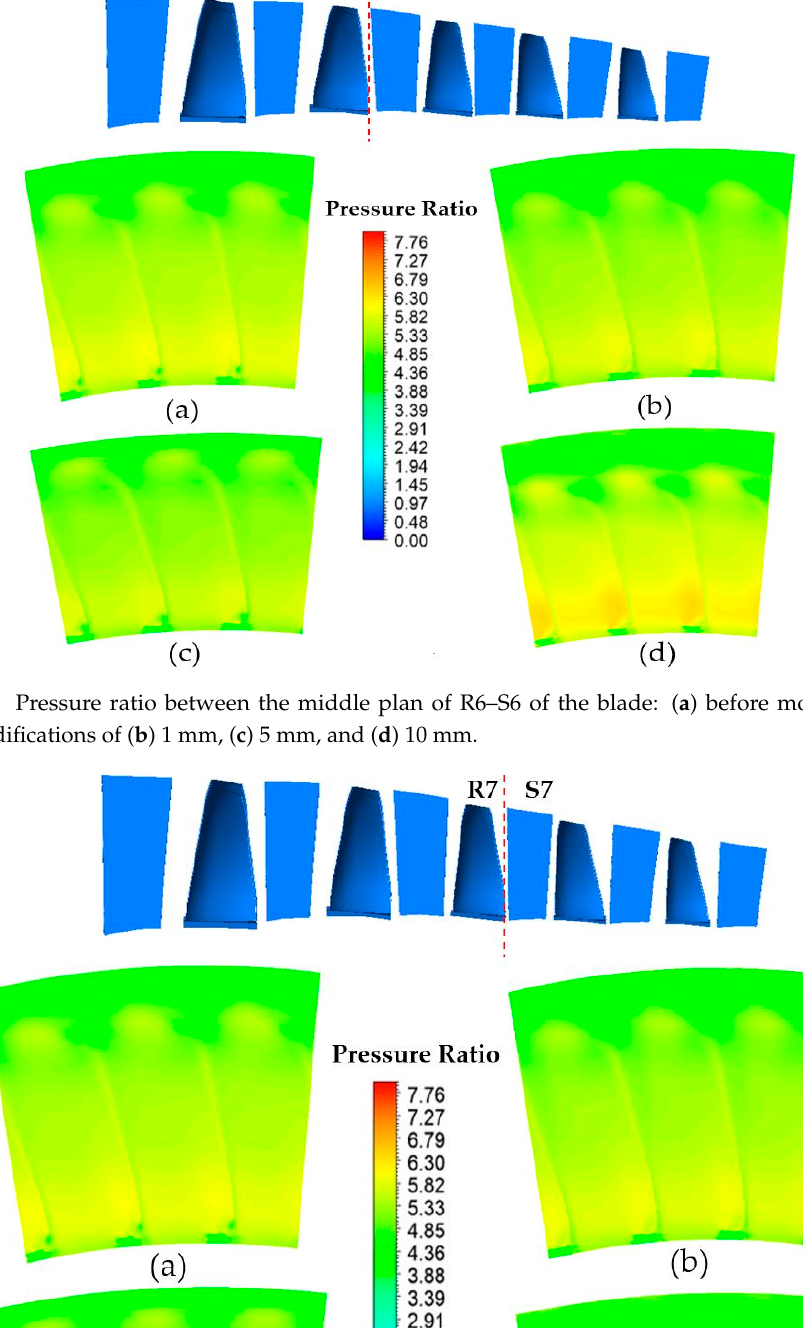
Figure 9. Pressure ratio between the middle plan of R7–S7 of the blade: ( a ) before modification, after modifications of ( b ) 1 mm, ( c ) 5 mm, and ( d ) 10 mm.